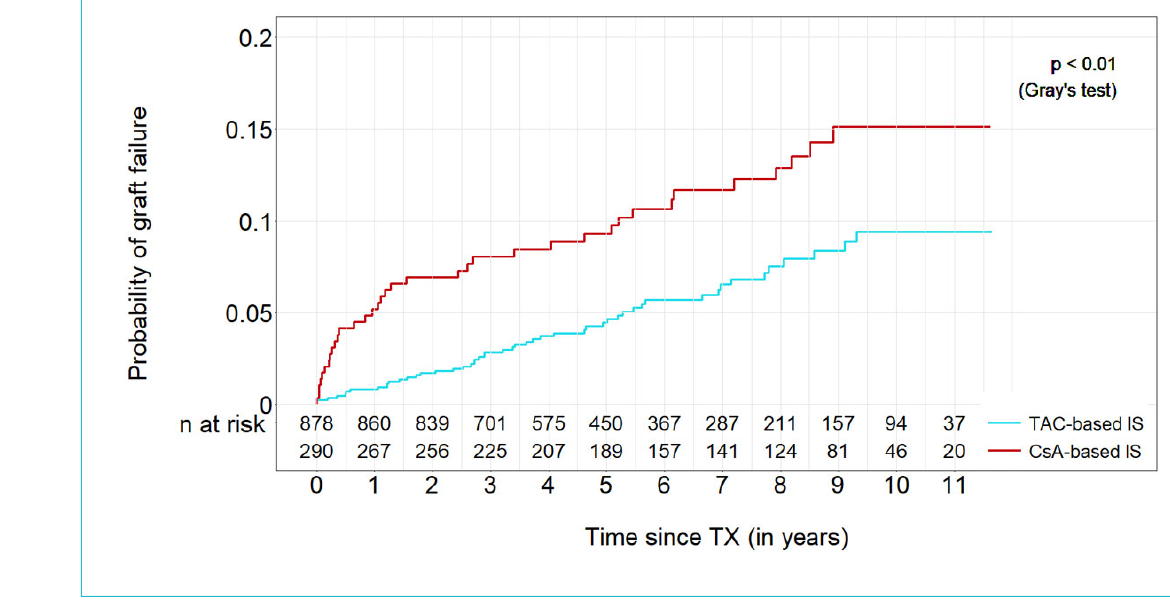
Figure 2: Renal allograft function displayed as estimated glomerular filtration rate (eGFR in ml/min/1.73m 2 ).TX = transplantation; IS = im- munosuppression“TAC-based” was defined as the combination of prednisone, tacrolimus and mycophenolate mofetil. “CsA-based” corre- sponds to the combination of ciclosporin, prednisone and mycophenolate